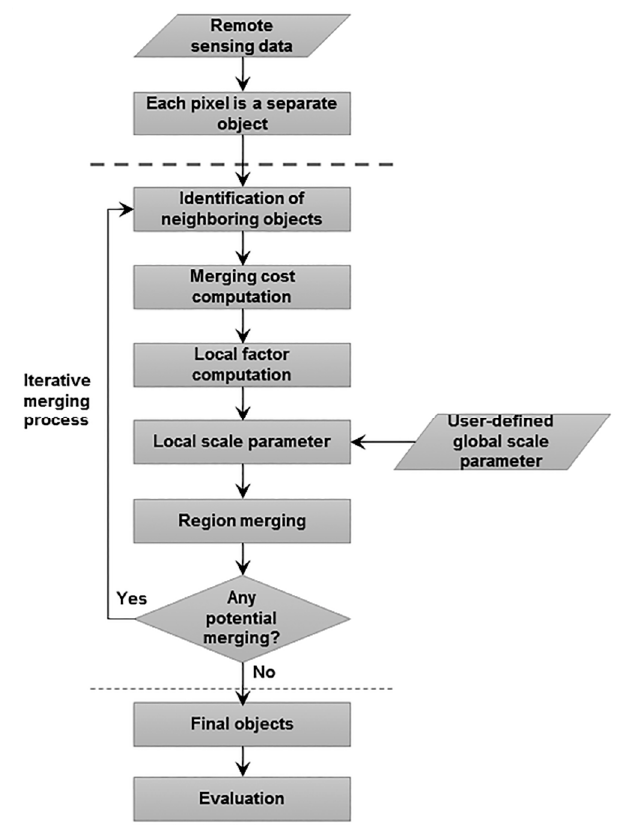
Figure 1. Region merging with local scale parameters workflow.